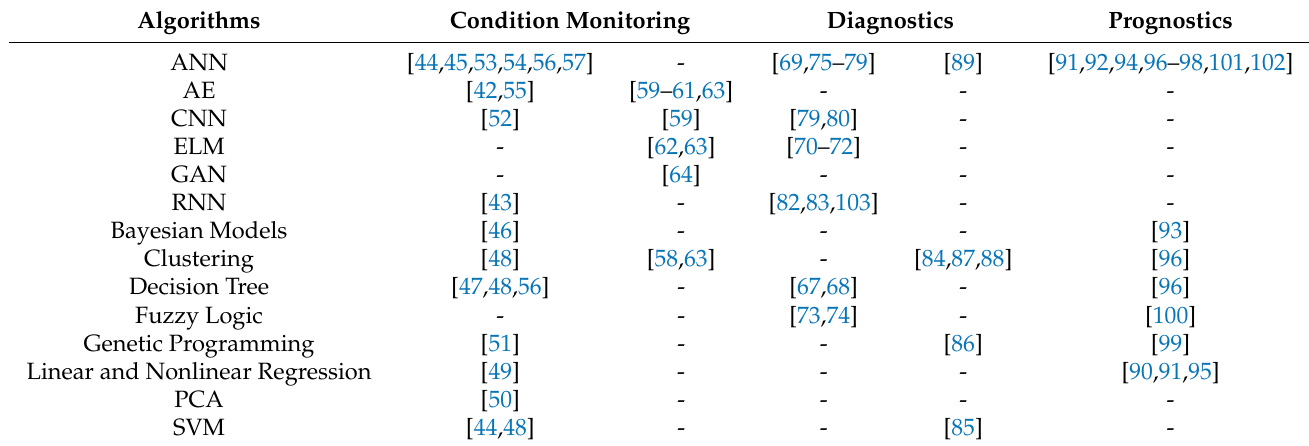
Table 7. Classification summary of reviewed